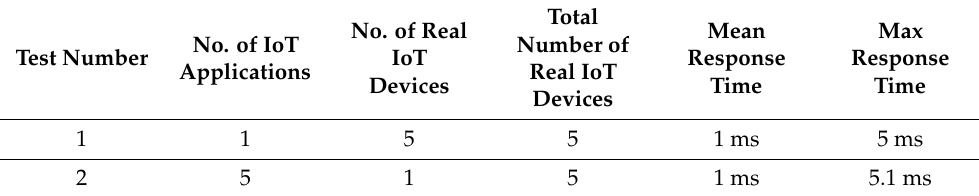
Table 4. Results of each test in the real IoT devices